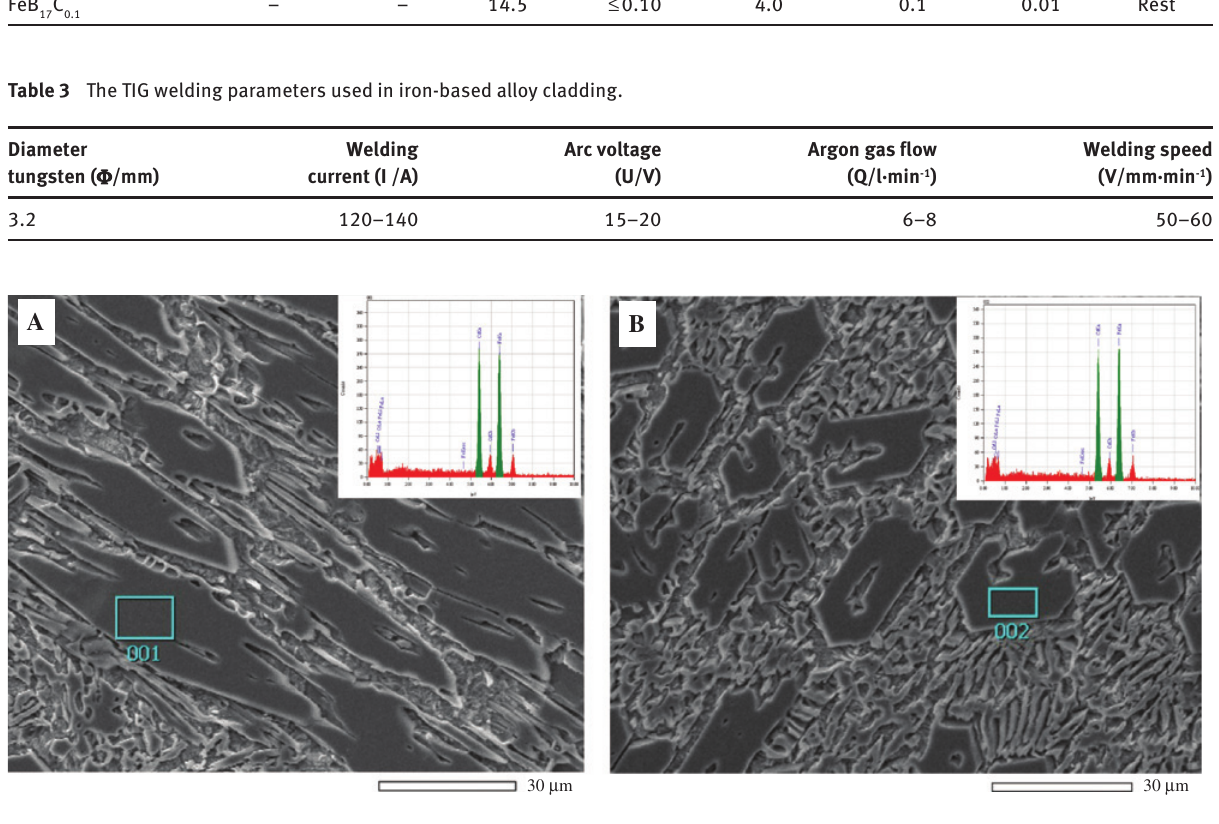
Figure 1 Microstructure and chemical composition (EDS) analysis of FeCrC alloy cladding: (A) the edge in the cladding layer, (B) the center in the cladding